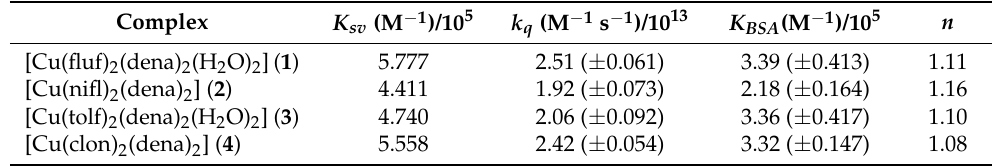
Table 8. Values of the Stern–Volmer quenching constant ( K sv ), quenching constant ( k q ), association binding constant ( K BSA ) and n (number of binding sites for albumin) obtained for the interaction of 1 – 4 with bovine serum albumin.